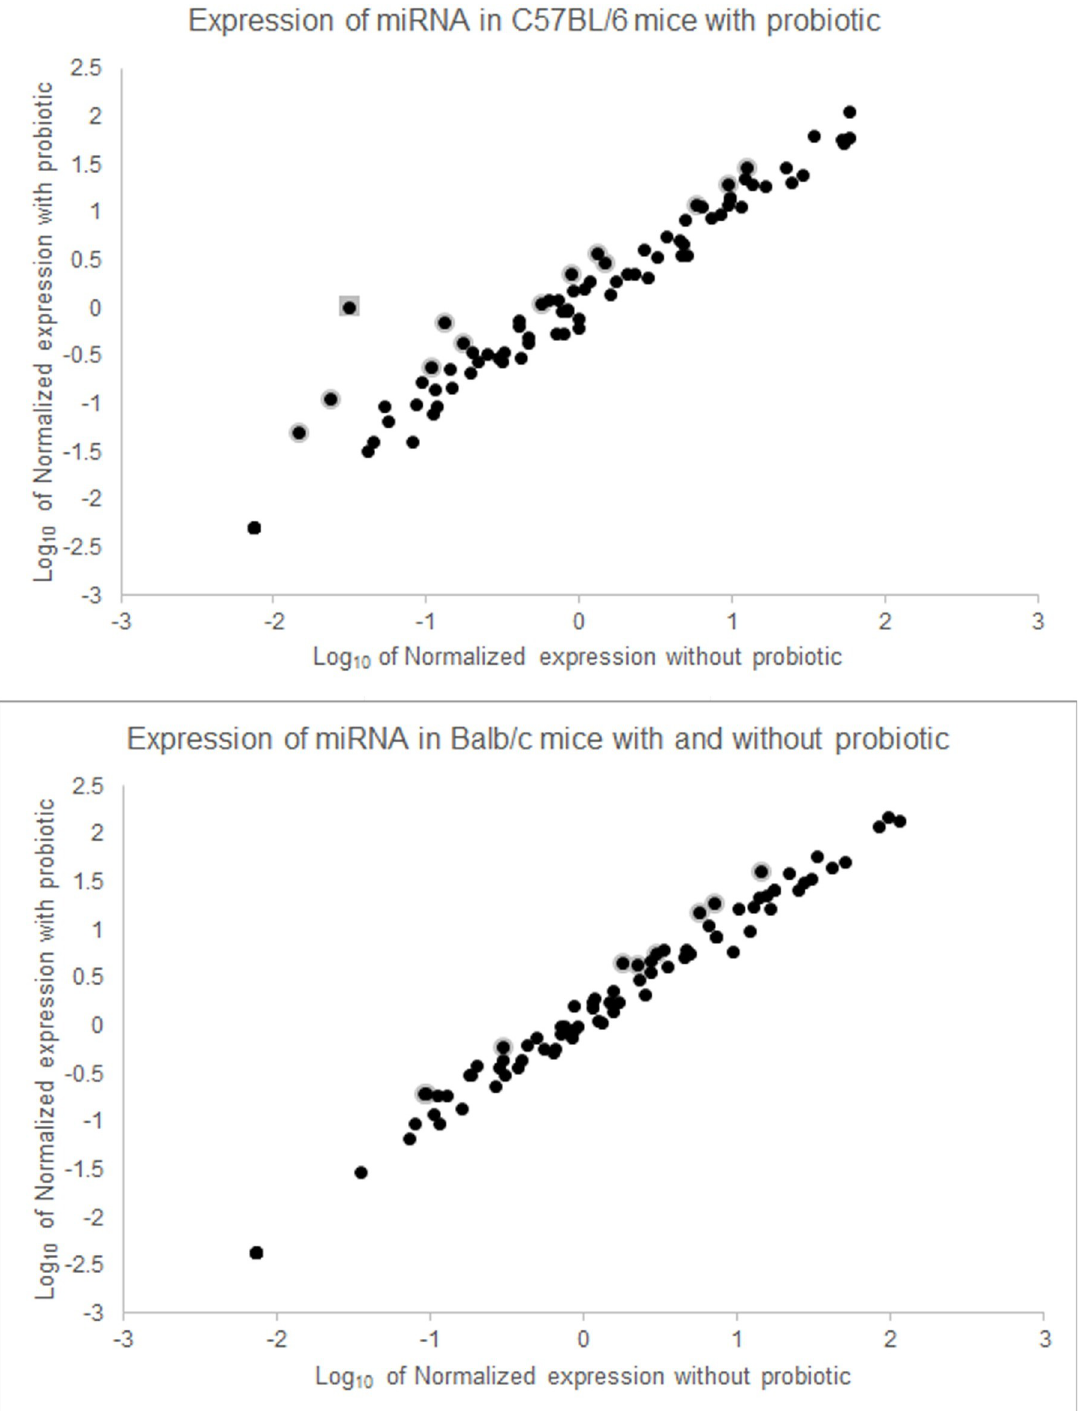
Fig 2. B . longum changes neurologically relevant miRNA expression in both Balb/c and C57BL/6 mice. Mice that have been fed 10 9 B . longum for three weeks show changes in expression of some neurologically relevant miRNAs in the brain. PCR arrays of miRNAs from the brains of C57BL/6 (top) and Balb/c (bottom) mice reveal that the bacteria does seem to influence gene expression of miRNAs in the brain. Those with greater than 2-fold difference in expression are highlighted in grey. mmu-mir-652-3p is marked with a square in the top graph (see below).